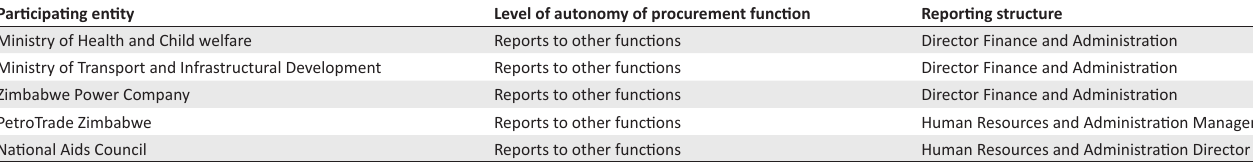
TABLE 2: Level of